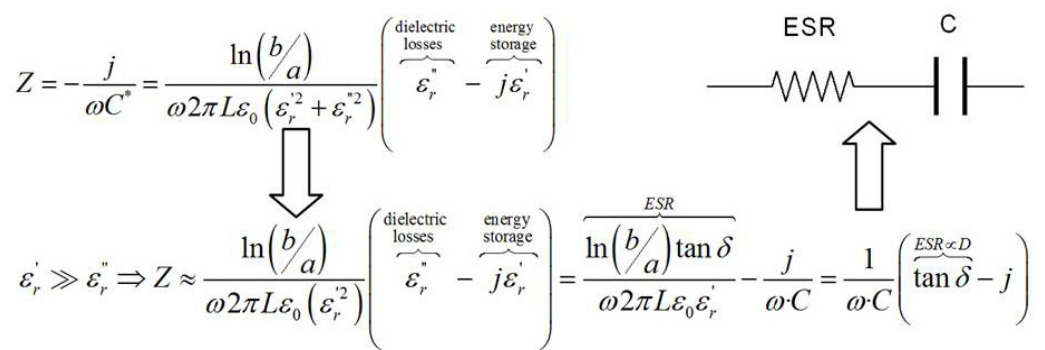
Figure 2. Equivalent circuit for cylindrical